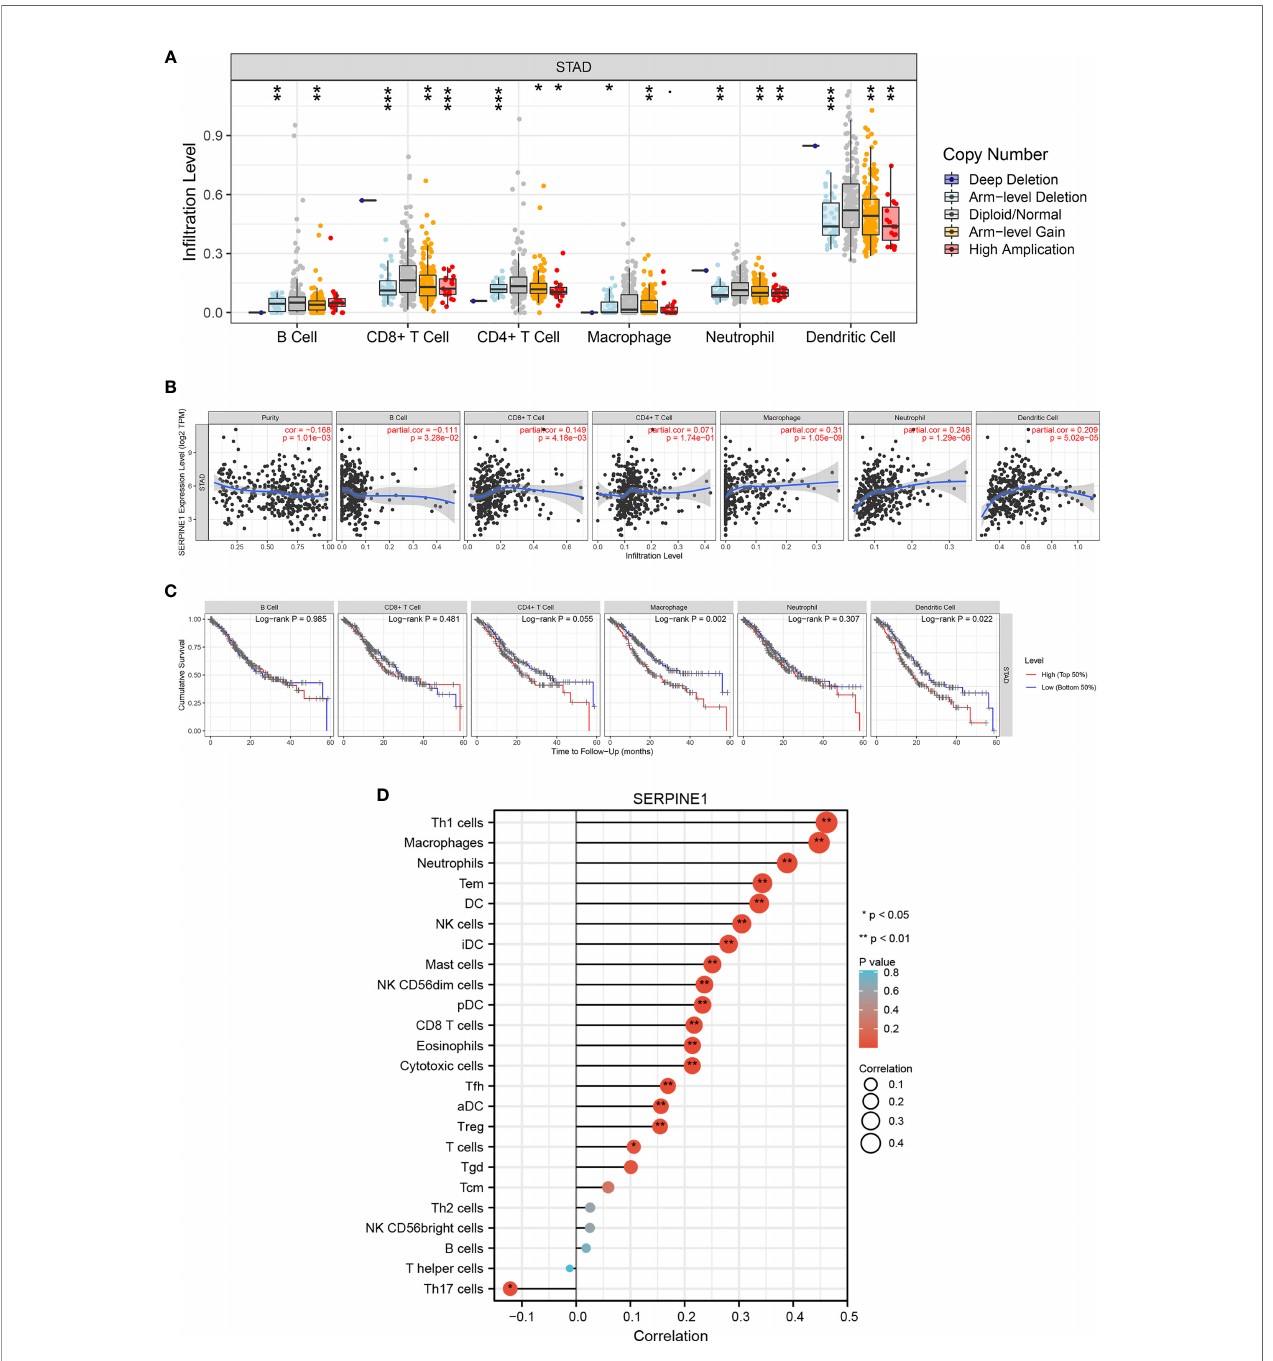
FIGURE 10 | Correlation analysis of SERPINE1 expression and immune in fi ltration in STAD. (A) Association between SERPINE1 gene copy number and immune cell in fi ltration levels in STAD cohorts. (B) Correlation of SERPINE1 expression with immune in fi ltration level in STAD. (C) K-M plots of immune in fi ltration and overall survival rate of STAD. (D) Lollipop graphs of correlation between SERPINE1 and biomarkers of 24 immune cells. * p < 0.05, ** p < 0.01, *** p <